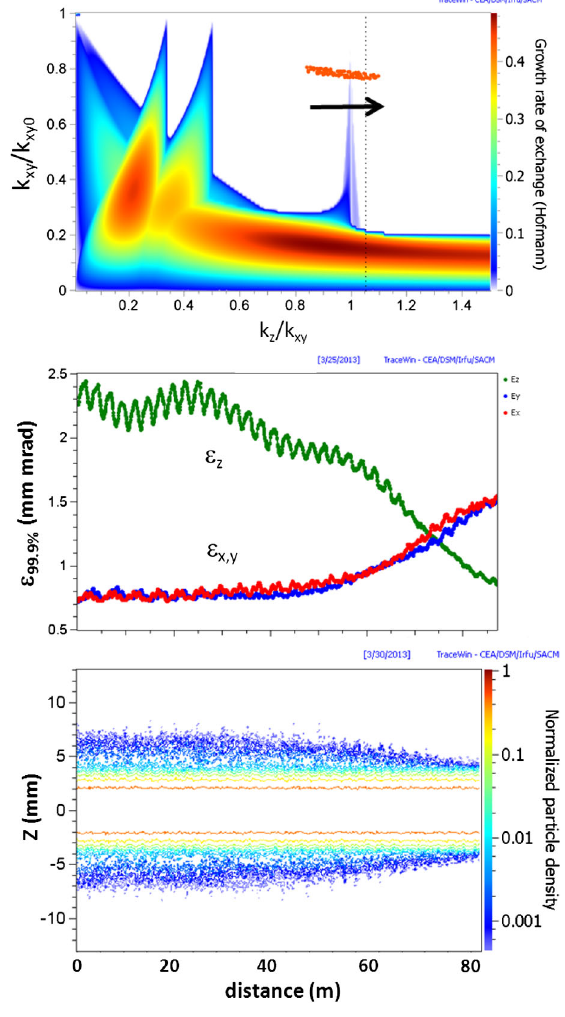
FIG. 5. Extra halo in longitudinal plane with nearly equiparti- tioned core: Tune footprint on stability chart for (cid:2) z =(cid:2) x ¼ 0 : 95 (top); rms and 99.9% emittances (middle); and z evolution